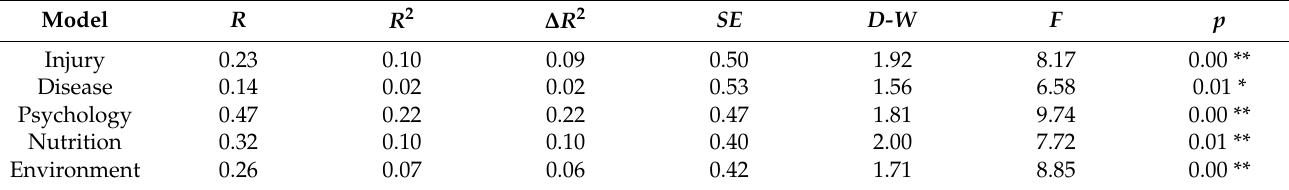
Table 5. Regression model and variance analysis of different risk